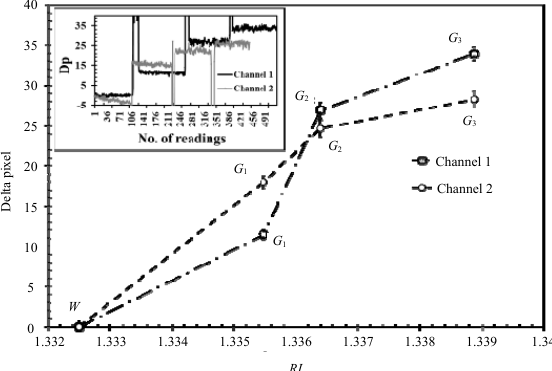
Fig. 14 Response of Channels 1 and 2 for different RI solutions, plotted with respect to delta pixel. The inset shows the recording of system response with different